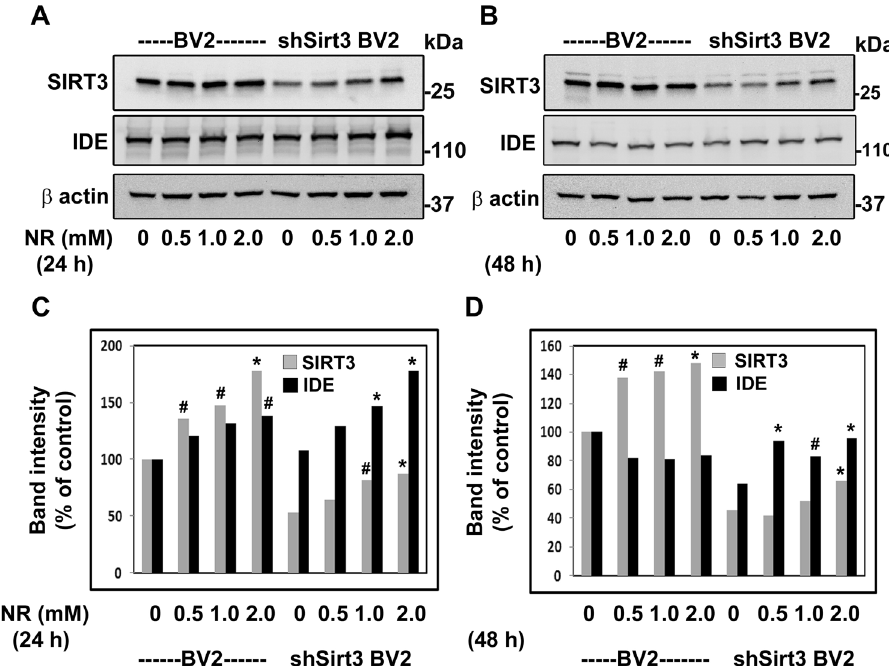
Figure 7. Effects of SIRT3 activation by NR in cultured mouse microglial cell line: BV2 and Sirt3-silenced shSirt3BV2 cells were cultured in the absence and presence of increasing concentrations of nicotinamide riboside (NR) for 24 h ( A , C ) and 48 h ( B , D ). The cell lysates were prepared and immunoblotted for SIRT3 and IDE ( A , B ). Representative cropped images are presented for clarity and conciseness while the composite color images of full blots are presented in Supplementary Figure. The blots were quantitated by scanning and corrected for the levels of β actin ( C , D ). Mean ± SE of results from 3 independent experiments are presented. #, P < 0.05; *, P < 0.01; **, P < 0.001 versus untreated control in respective cell lines, compared to Control untreated